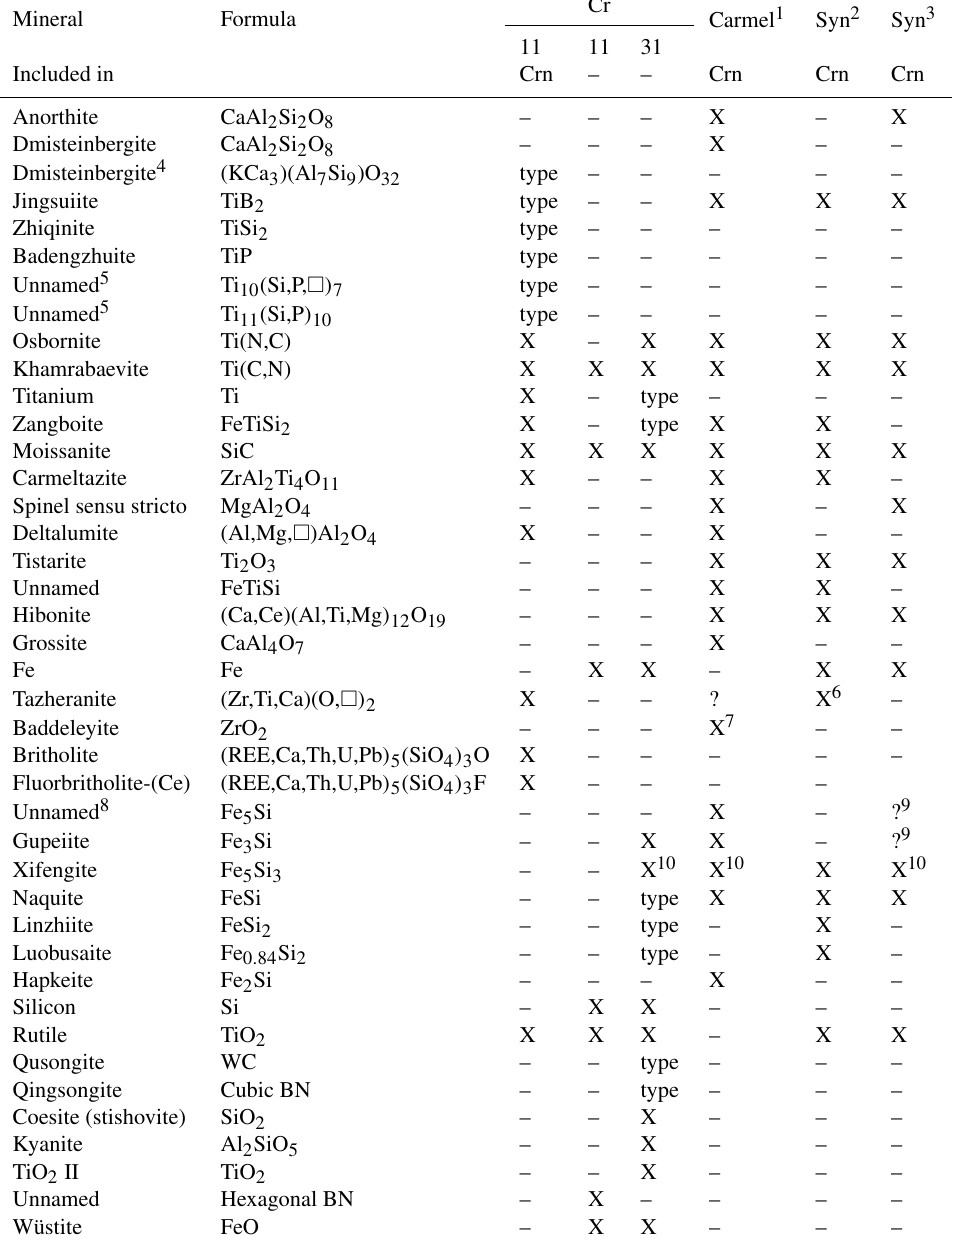
Table 1. Minerals found in chromitites in the Luobusa ophiolite compared to minerals from Mount Carmel, Israel, and compounds in fused alumina abrasive. Note that REE represents rare-Earth elements, (cid:3) represents vacancy, X represents a mineral that has been reported, and ? represents a questionable